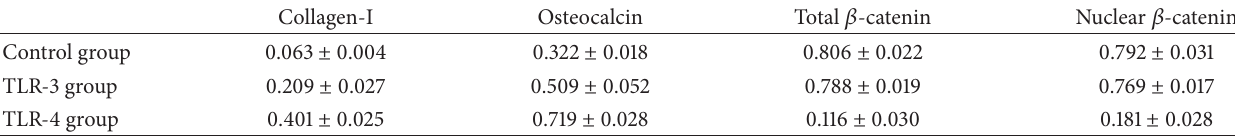
Table 1: Quantitative analysis of Western blotting ( 𝑥 ± 𝑠